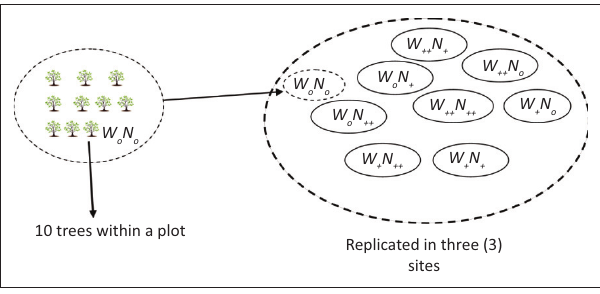
Replicated in three (3) sites